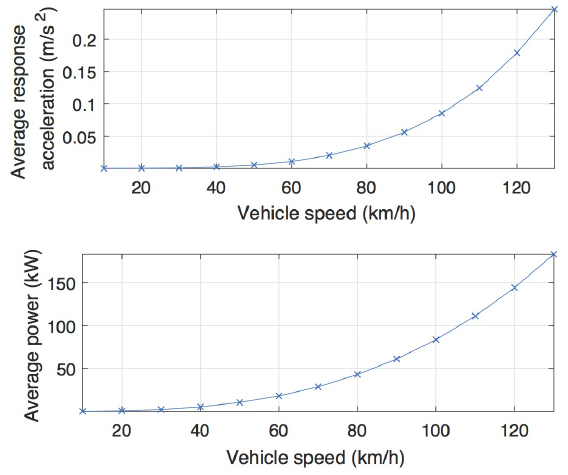
Figure 12. Average response acceleration and average recoverable power from one electromagnetic suspension on a wheel with varying vehicle velocities. Weight on top of one suspension assumed at 400